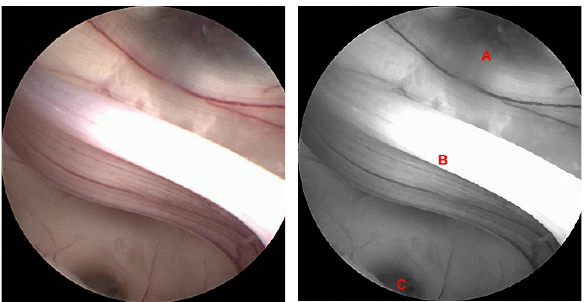
Fig. 17. Postmammillary recess (A), interthalamic adhesion (B), cerebral aqueduct entrance